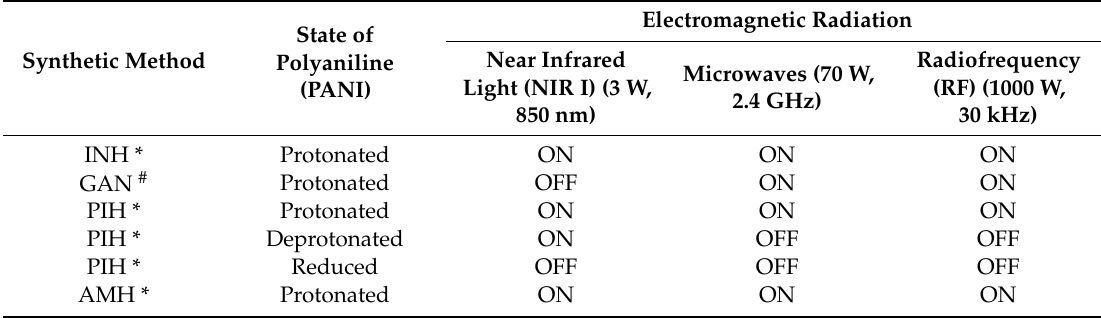
Table 1. Comparative e ff ect of di ff erent forms of electromagnetic radiation (ER) on the composite materials produced by di ff erent synthetic